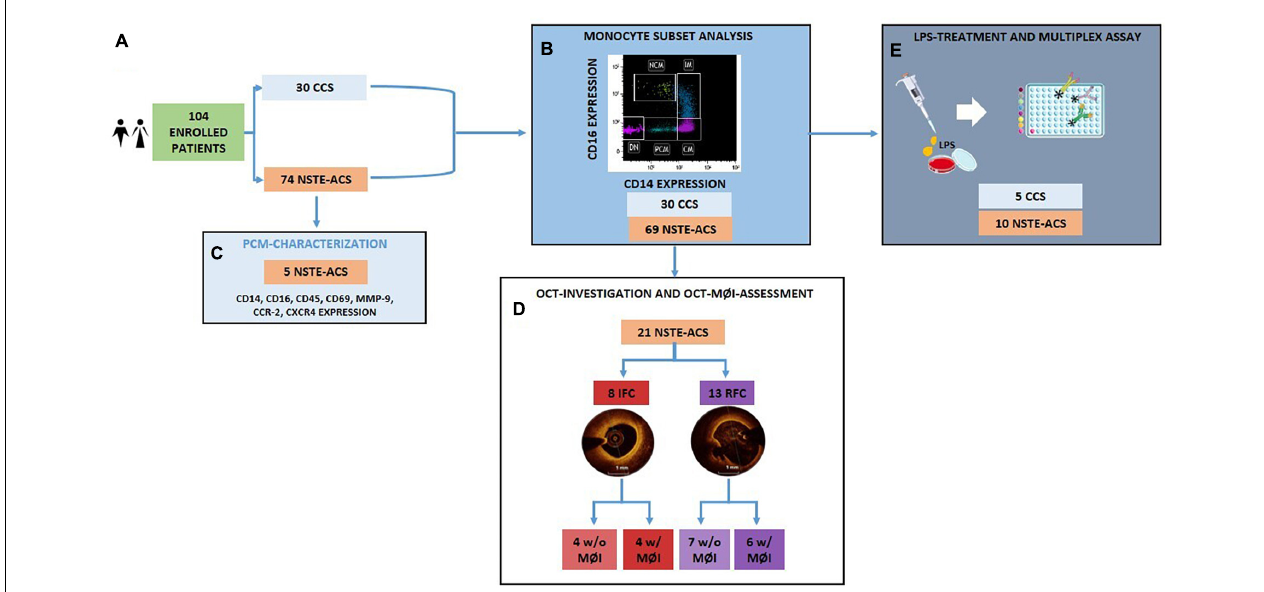
FIGURE 1 | Flowchart showing the allocation of the enrolled patient population within each experimental procedure. (A) Among the 104 enrolled patients, 30 were CCS and 74 were NSTE-ACS; (B) The analysis of distribution of circulating monocyte subsets was performed according to CD14 and CD16 expression on 30 CCS and 69 NSTE-ACS patients; (C) 5 new NSTE-ACS patients were enrolled to characterize a novel monocyte subpopulation; (D) 21 of the 69 NSTE-ACS patients underwent OCT investigation and OCT-MØI assessment, resulting in 8 IFC and 13 RFC, respectively; (E) Lastly, 5 CCS and 10 NSTE-ACS patients of the 30 CCS and 69 NSTE-ACS, respectively, were employed for the in vitro LPS-treatment and cytokine multiplex assay. CCS, chronic coronary syndrome, IFC, intact fibrous cap; LPS, lipopolysaccharides; MØI, machrophage infiltration; NSTE-ACS, non ST-elevation acute coronary syndrome; PBMCs, peripheral blood mononuclear cells; RFC, ruptured fibrous cap; w/o, without; w/with. Art images from